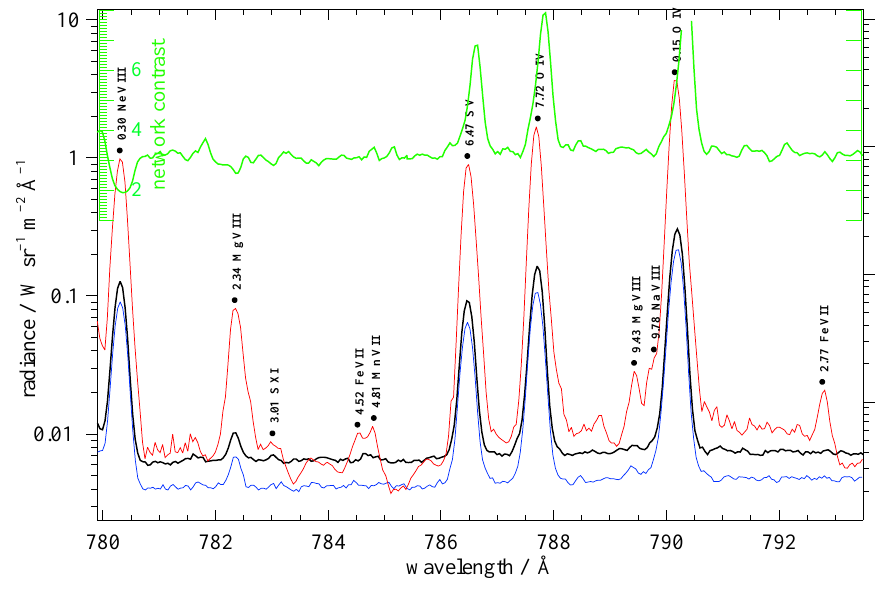
Fig. 4. Cutout of the SUMER spectral atlas (Curdt et al., 2001) showing radiances of average QS (black), sunspot (red), coronal hole (blue). The network contrast (ratio bright-network/cell-interior in green) increases by a factor of > 2 in TR lines and the peaks are clearly redshifted.